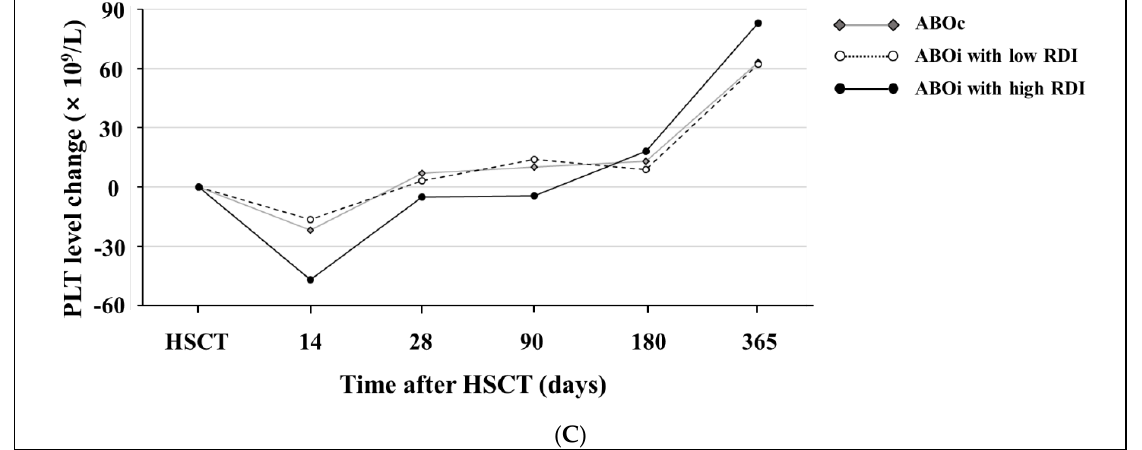
Figure 2. Dynamics of Hb, WBC, and PLT level changes during 1 year after HSCT (ABOc = 53, ABOi with low RDI = 36, ABOi with high RDI = 14). The changes in the levels of ( A ) Hb, ( B ) WBC, and ( C ) PLT represent the results of subtracting the initial value on the day of HSCT from the changed value after 14, 28, 90, 180, and 365 days. The horizontal gray solid line represents the ABOc group, the horizontal dotted black line represents the ABOi with low RDI group, and the horizontal solid black line represents the ABOi with high RDI group. Abbreviations: Hb, hemoglobin; WBC, white blood cell; PLT, platelet; ABOc, ABO-compatible transplantation; ABOi, ABO-incompatible transplantation; RDI, recipient-derived isoagglutinin; HSCT, hematopoietic stem cell